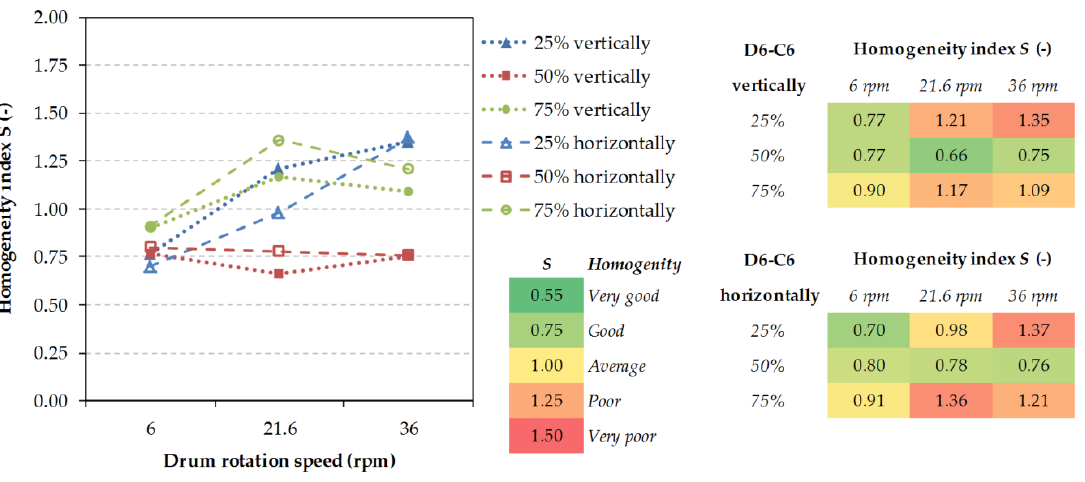
Figure 9. Resulting homogeneity indices for different operating conditions (D6-C6 particles).